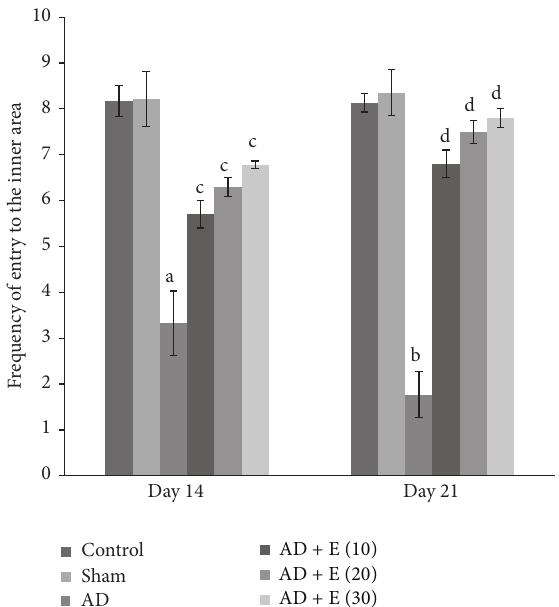
Figure 1: The frequency of entry to the inner area in an elevated open space with a novel object (for anxiety status) of different experimentalgroupsofrats. a cADversuscontrol/shamoperatedrats at day 14 ( 𝑝 < 0.01 ), b cAD versus control/sham operated rats at day 21 ( 𝑝 < 0.001 ), c cAD versus etoricoxib treated cAD at all the doses at day 14 ( 𝑝 < 0.001 ), and d cAD versus etoricoxib treated cAD at all the doses at day 21 ( 𝑝 < 0.001 ). AD: intracerebroventricular colchicine injected Alzheimer Disease rats, AD + E (10): AD rats treated with 10 mg/kg body weight of etoricoxib, AD + E (20): AD rats treated with 20 mg/kg body weight of etoricoxib, and AD + E (30): AD rats treated with 30mg/kg body weight of etoricoxib. Values are expressed in mean ± SEM ( 𝑛 = 6 in each group).